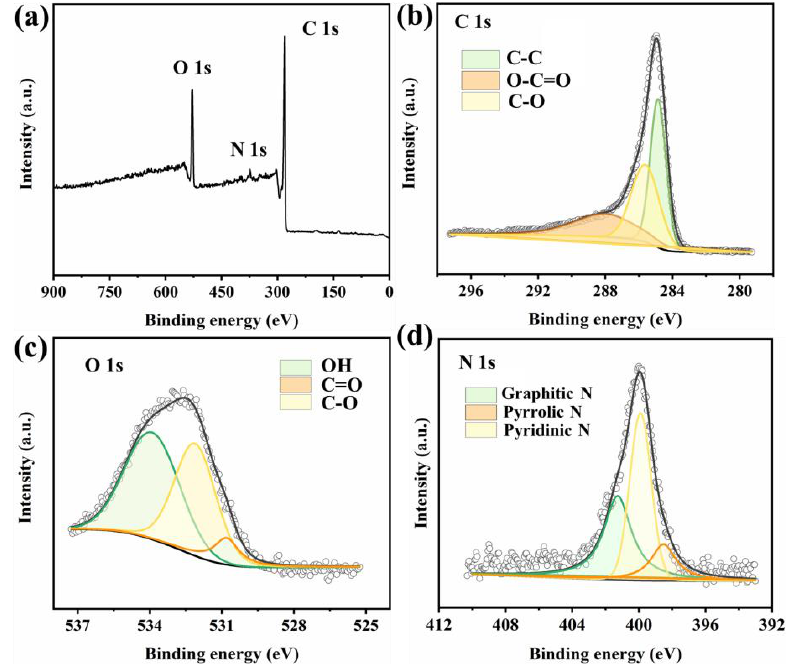
Figure 5. XPS total spectrum ( a ), C 1s spectrum ( b ), O1s spectrum ( c ) and N1s spectrum ( d ) of carbon nanosheets.